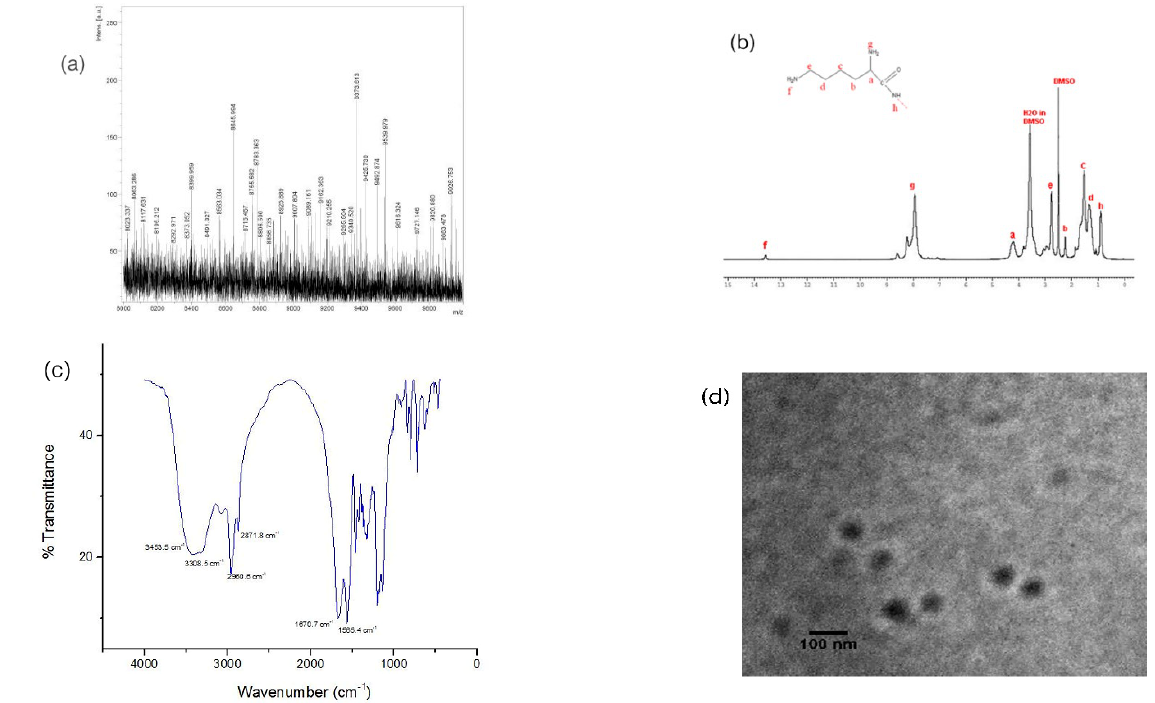
Figure 1. ( a ) MALDI-TOF MS profile: The [M+H] + value calculated for C 456 H 1030 N 132 O 63 was 9372.86 Da and found to be 9373.613 Da; ( b ) NMR spectra (400 MHz, DMSO- d 6 ), ppm: 0.911 (s, 24H, NH), 1.343, 1.538, 2.253 (m, 154H, CH 2 ), 2.762 (m, 51H, CH 2 –NH 2 ), 4.204 ( s, 21H, CH), 7.943, 8.232, 8.599 (t, 80H, NH2), and 13.584 (s, 2H, NH2); ( c ) FTIR spectra: wavenumber = 3453.5 cm −1 (m), 3308.5 cm −1 (m), 2960.6 cm −1 (m), 2871.8 cm −1 (m), 1670.7 cm −1 (s), and 1565.4 cm − 1 (s); ( d ) TEM image of P 4 LDN.